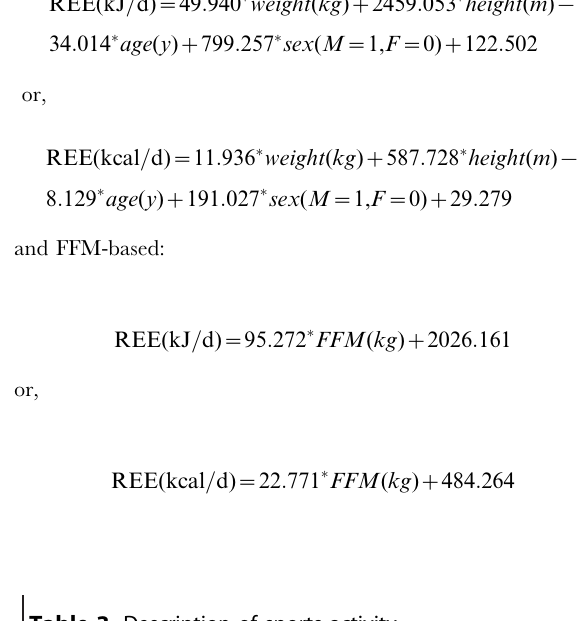
Table 3. Description of sports